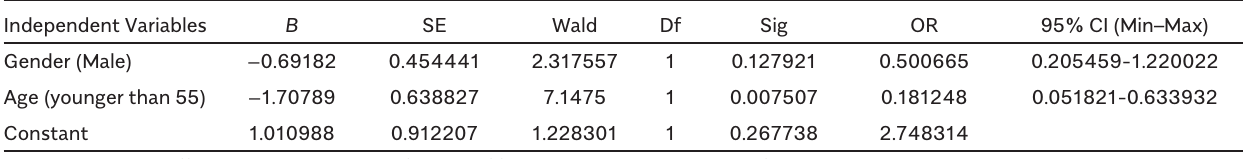
Table 8. Results of Logistic Regressions Analysis According to the Variables in Patient Group (Gastric Cancer and Duodenal Ulcer Cases) Independent Variables B SE Wald Df Sig